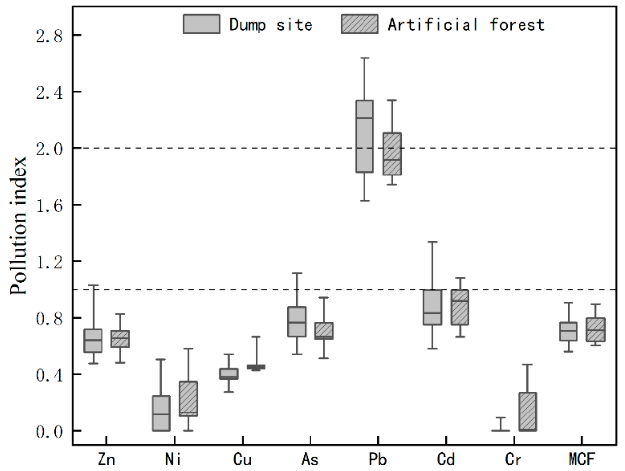
Figure 2. Boxplot of Heavy Metal Pollution Index.